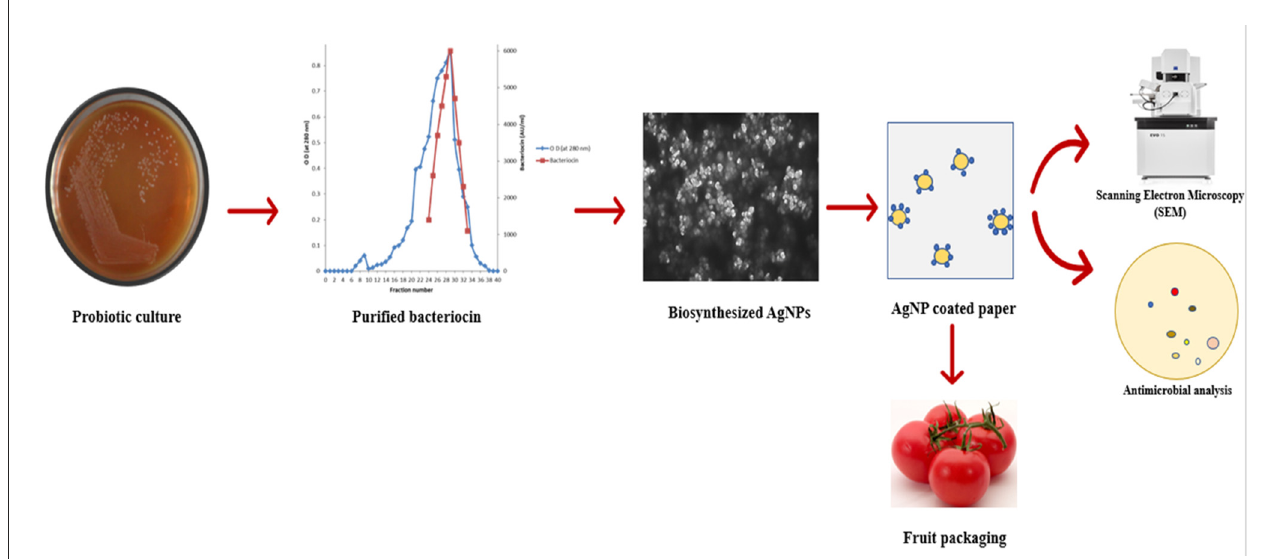
FIGURE1 Schematic representation of synthesis of AgNP s by bacteriocins and their application in food